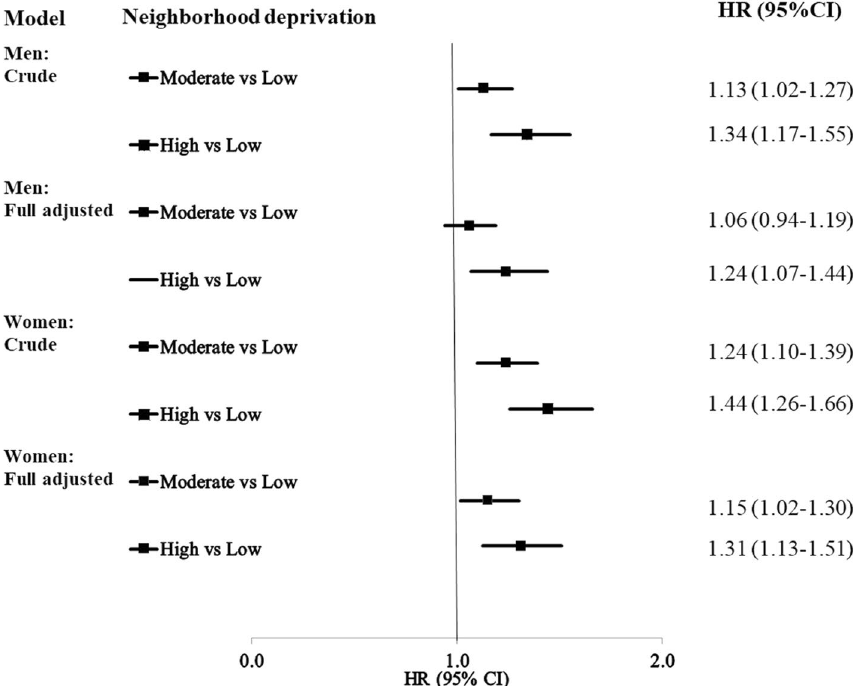
Figure 1. Hazard ratios (HR) and 95% confidence intervals (CI) for incident CHD in patients with bipolar disorder. The full model is adjusted for all the individual level sociodemographic variables and comorbidities. CHD Coronary heart disease HR Hazard ratio, CI Confidence